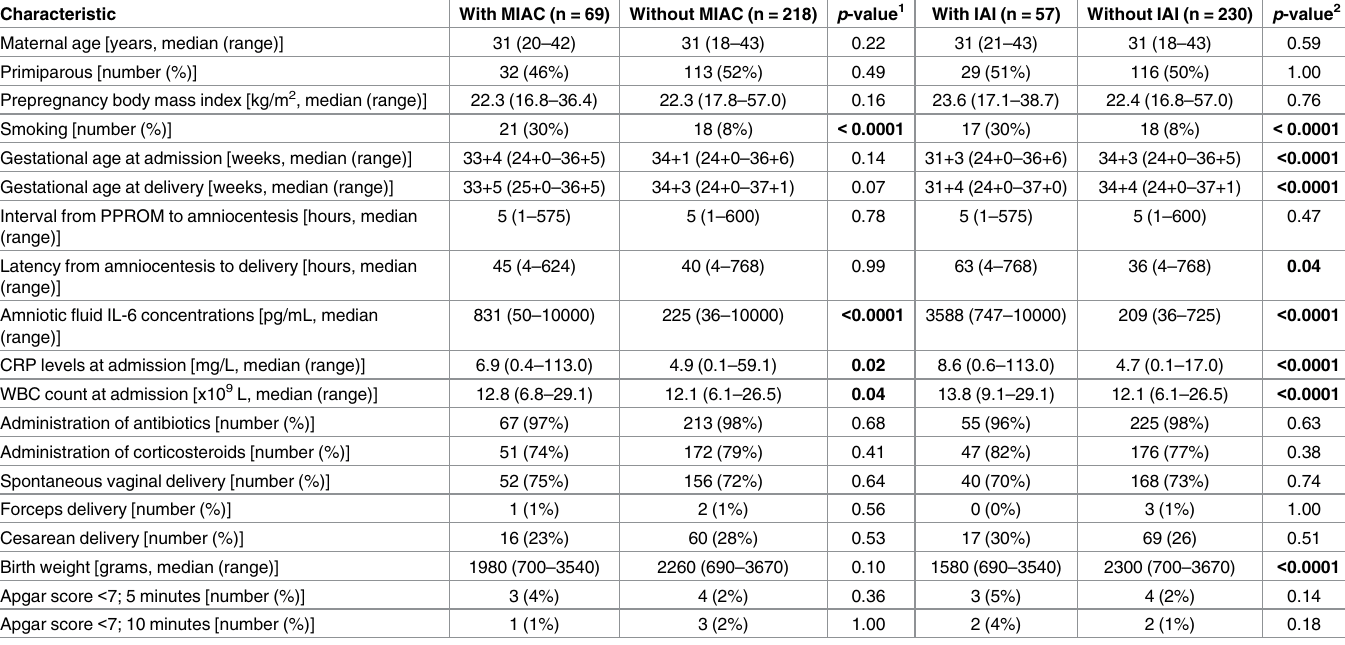
Table 1. Demographic and clinical characteristics of the women with PPROM with respect to the presence and the absence of MIAC and IAI. Characteristic With MIAC (n = 69) Without MIAC (n = 218) p -value 1